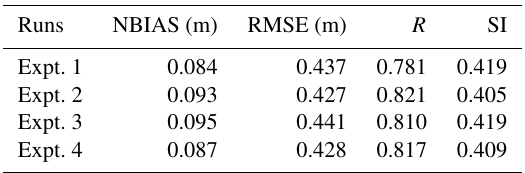
Table 3. Statistical comparison of altimeter-derived and wave- model-derived significant wave height H s ; normalized bias (NBIAS), root mean square error (RMSE), Pearson correlation co- efficient ( R ) and scatter index